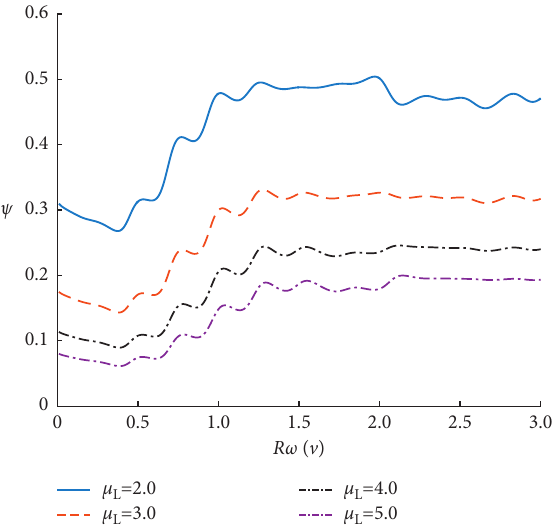
Figure 12: Curves of radial stress varying with frequency for different shear modulus ratio of lining